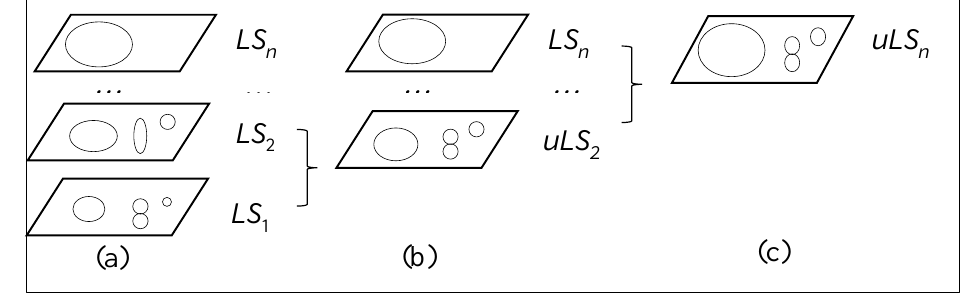
Figure 4. The integration of the series of slices. Initial layers ( a ), updated layers ( b ) and final layer ( c ).